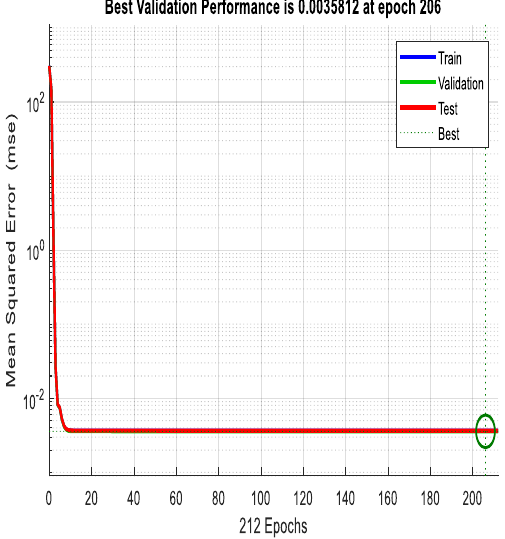
Figure 14. ANN performance. Figure 15 represents the ANN forecasting model on Simulink.